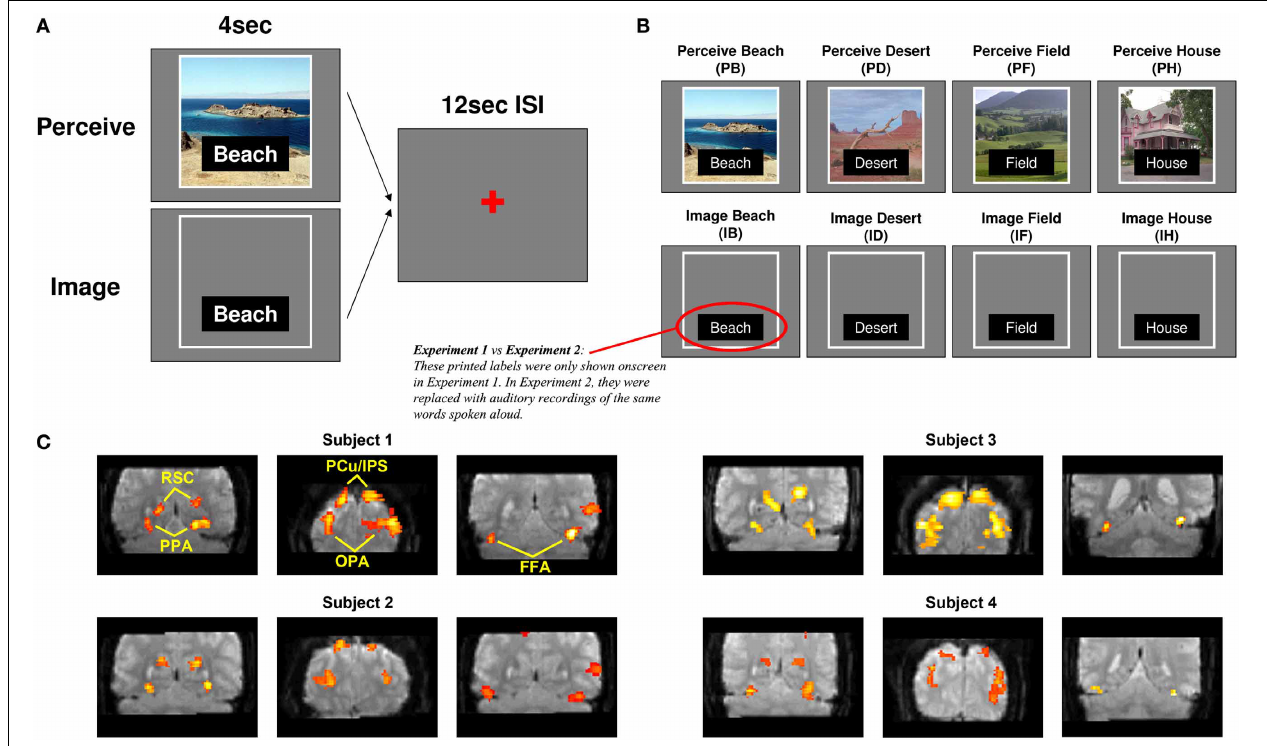
FIGURE 1 | Task design. (A) On Perceive trials, participants were shown a picture of a scene along with its label for 4s. On Image trials, participants saw only an empty frame with a label instructing which of the four scenes to imagine. The example displays shown here correspond to Experiment 1; in Experiment 2, the displays were the same except that the printed labels were removed entirely and replaced